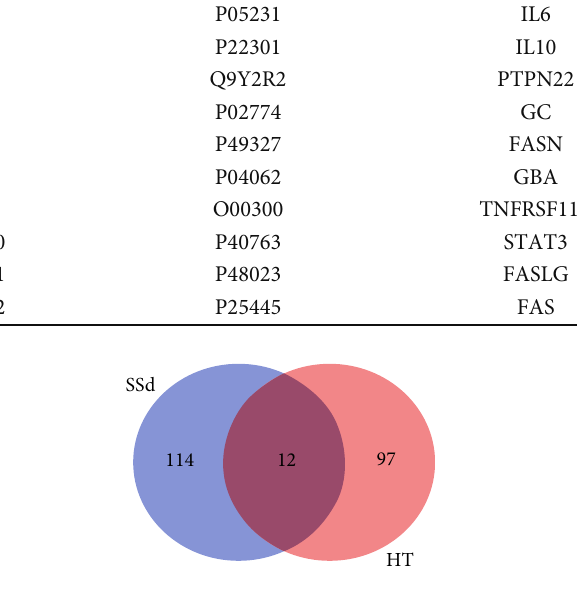
Figure 2: Number of HT and SSd-related gene targets. Table 4: Topological analysis of SSd-HT target network. Target